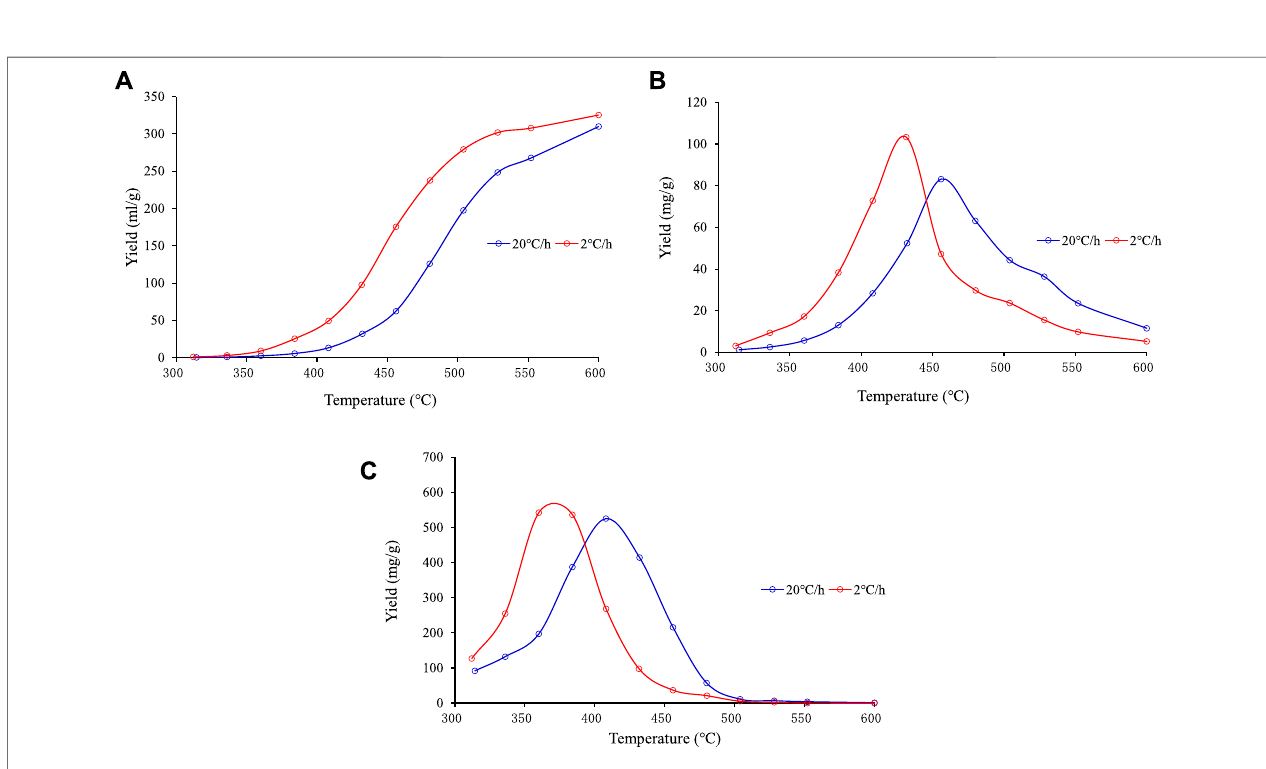
FIGURE 4| Hydrocarbon generation conversion rate at different temperatures ofsample No. Ninein the closed system experiments. (A) C 1 – 5 . (B) C 6 – 14 . (C) C 14+ .